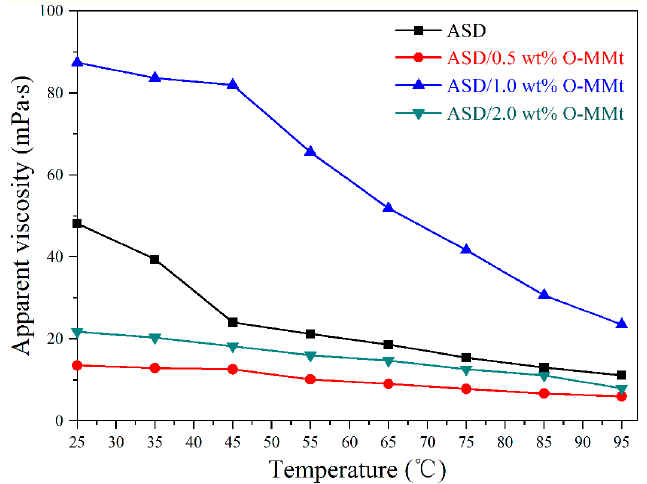
Figure 12. Relationships between apparent viscosity and temperature for ASD, ASD/0.5 wt% O- MMt, ASD/1.0 wt% O-MMt, and ASD/2.0 wt%